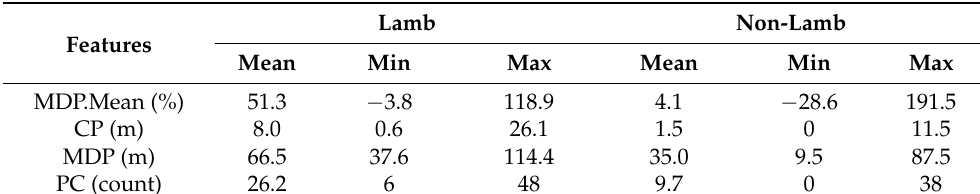
Table 3. Summary statistics for the top four features of the training (Trial One) dataset (determined by ROC curve analysis).